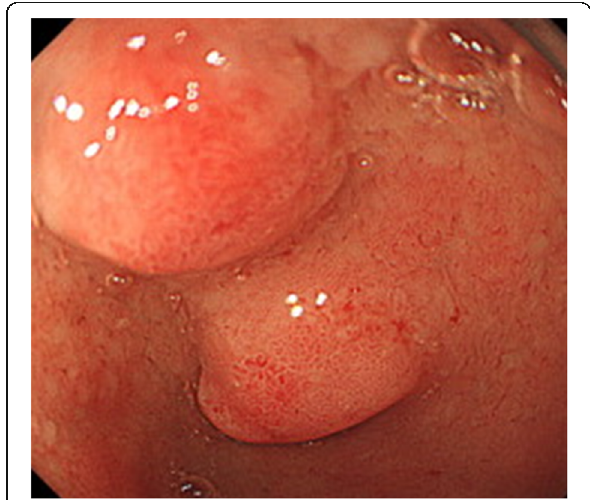
Fig. 2 Abdominal plain computed tomography (CT) findings. Plain CT on POD5 showing fluid collection in the anterior cavity of the pancreatic head